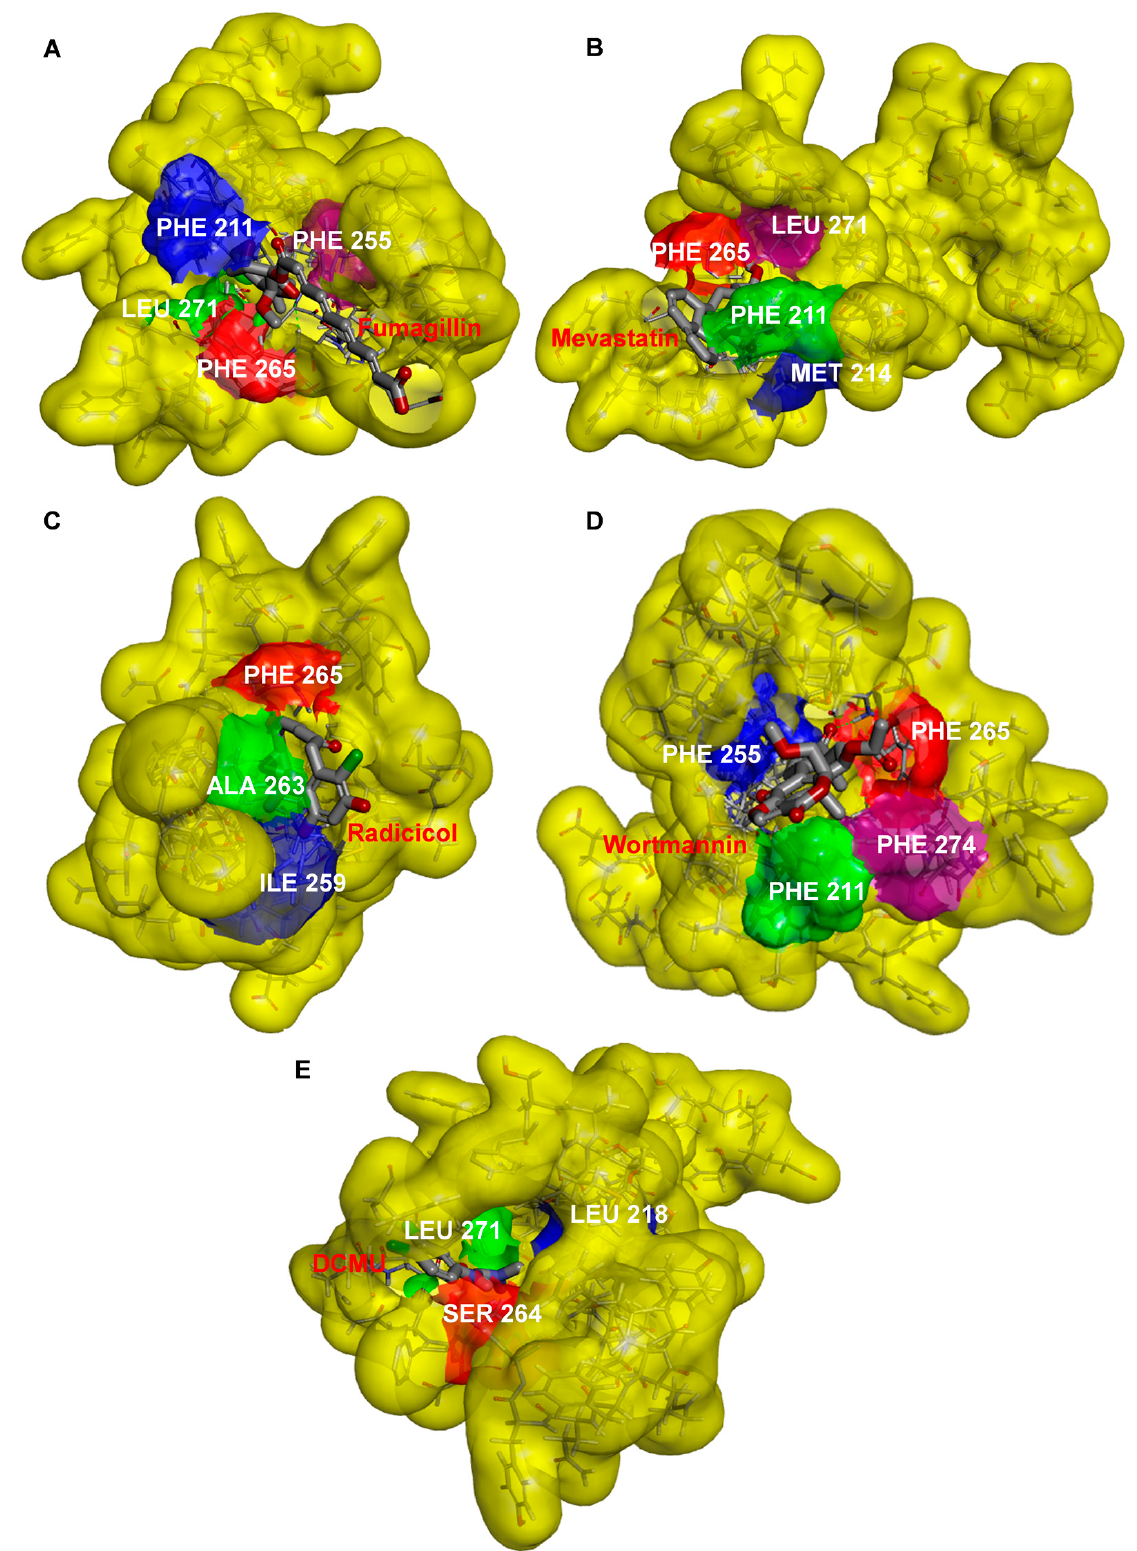
Figure 7. Docked poses of fumagillin ( A ), mevastatin ( B ), radicicol ( C ), wortmannin ( D ), and DCMU ( E ) inside the Q B binding site of D1 protein of C. reinhardtii